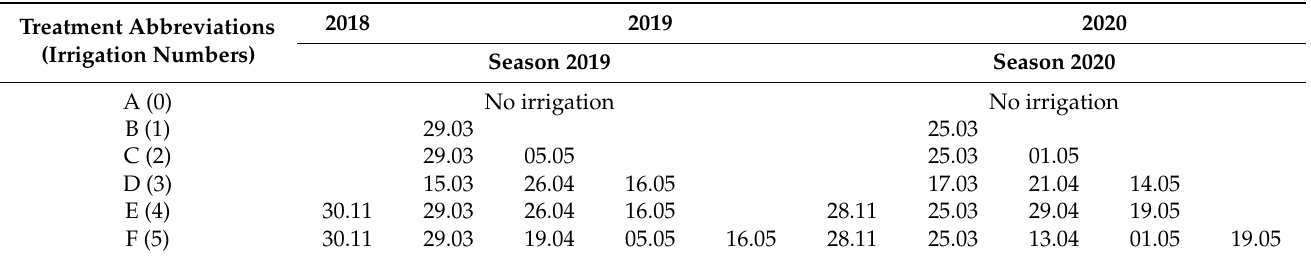
Table 1. Timing of each irrigation to different treatments for the season of 2019 and 2020 (60–80 mm per